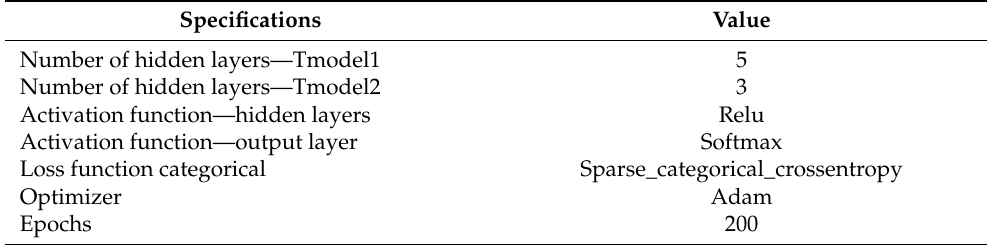
Table 10. Deep Learning Model